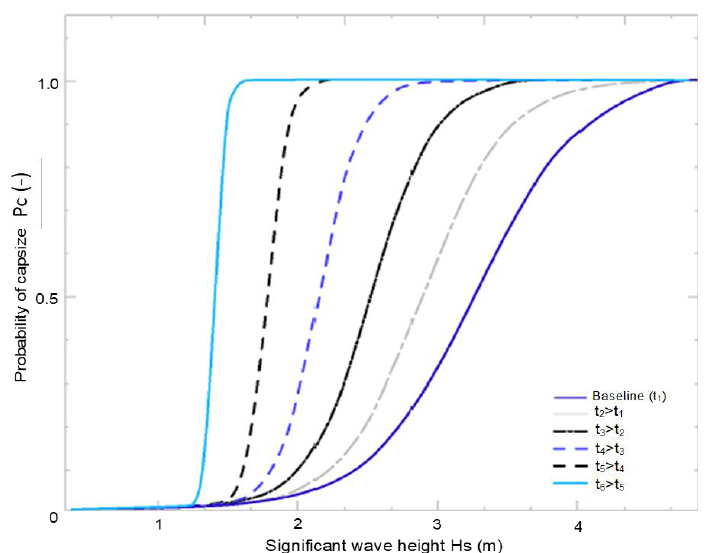
Figure 2. Change in shape of the capsize band with increasing exposure time t 1 for the baseline scenario (dark blue line). The capsize rate is derived for one damage, one loading condition and varying significant wave heights.